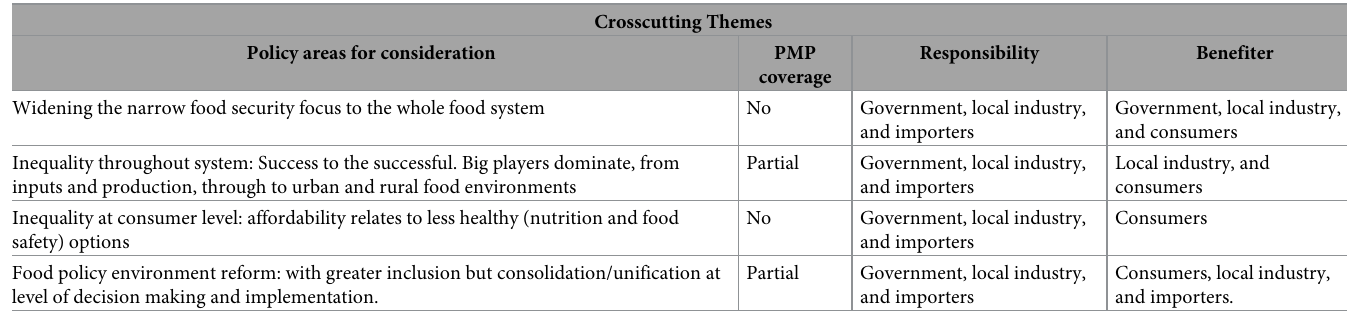
Table 5. Crosscutting themes for policy consideration (PMP = Poultry Master